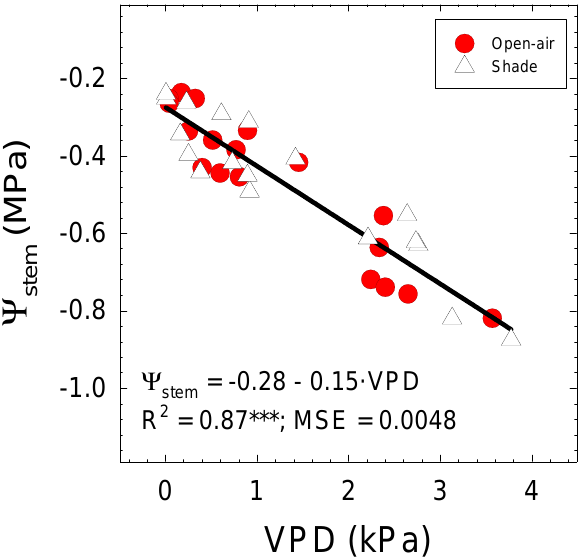
Figure 4. Relationship between daily stem water potential ( Ψ stem ) and vapour pressure deficit (VPD) values in lime trees grown in open-air (closed symbols) and shaded (open symbols) conditions on the two measurement days. Each point is the average of four replications. *** p ≤ 0.001. MSE = mean squared error.